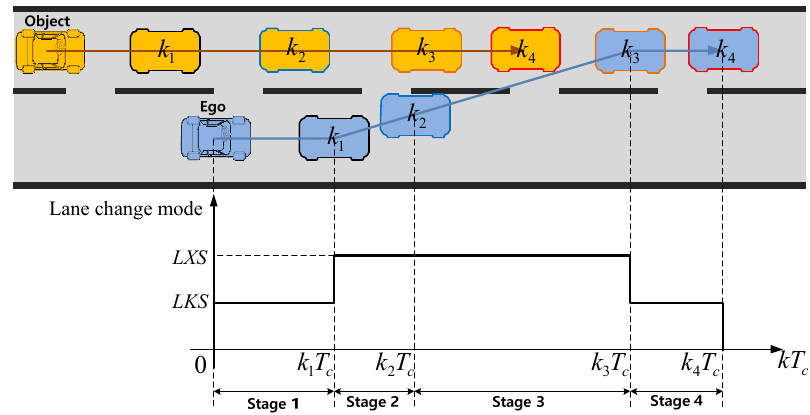
Figure 1. Strategy of autonomous